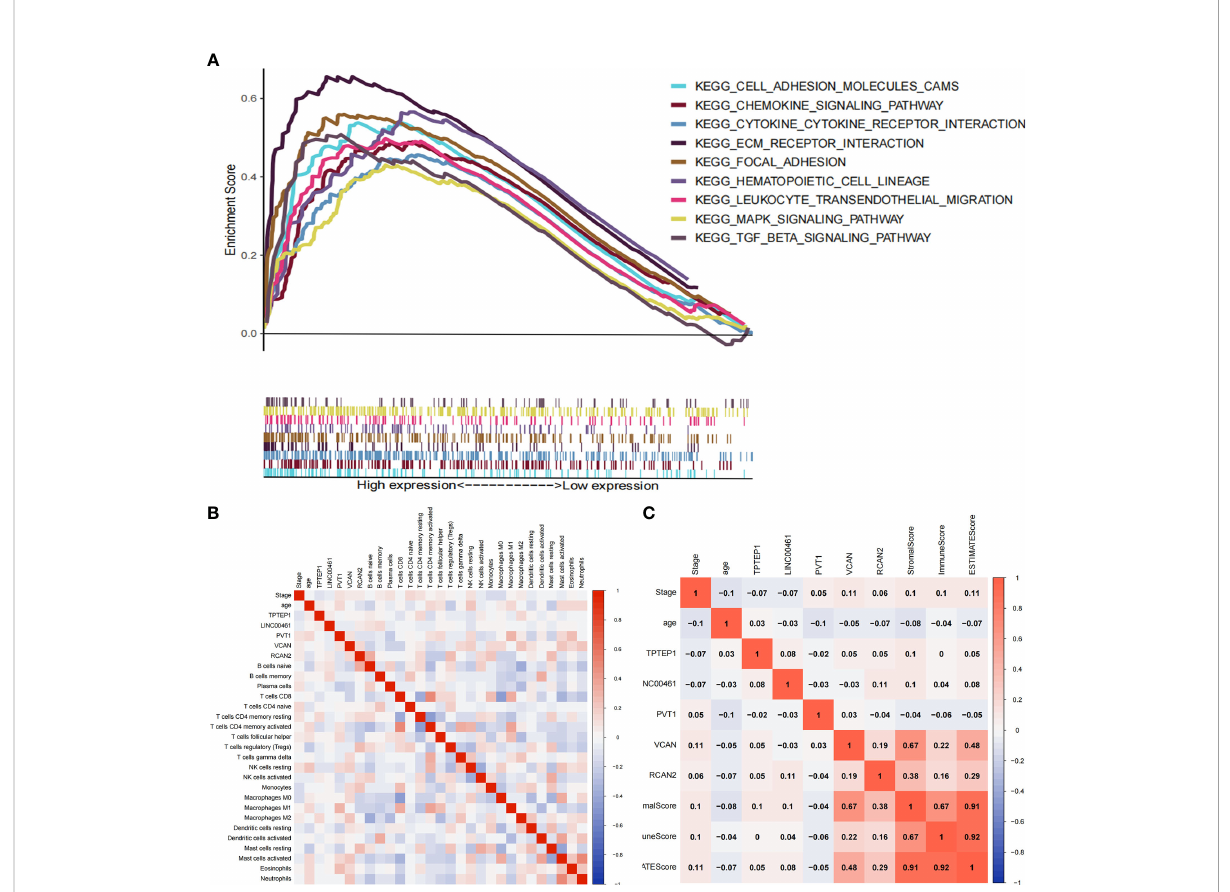
FIGURE 5 Correlation between ceRNAs and immune microenvironment of gastric cancer. (A) GSEA analysis of high-risk group divided by ceRNA related prognostic model. (B) Correlation analysis between ceRNAs and in fi ltrating immune cells. (C) Correlation analysis between ceRNAs and